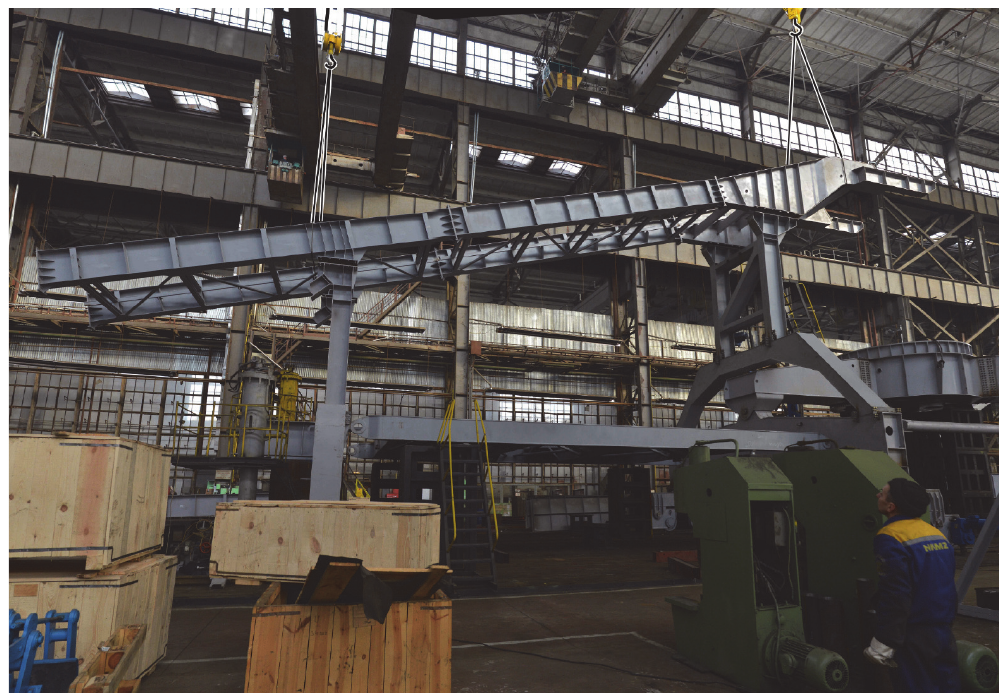
Figure 1: Typical plant photos of heavy cross-beam transportation with two overhead cranes.